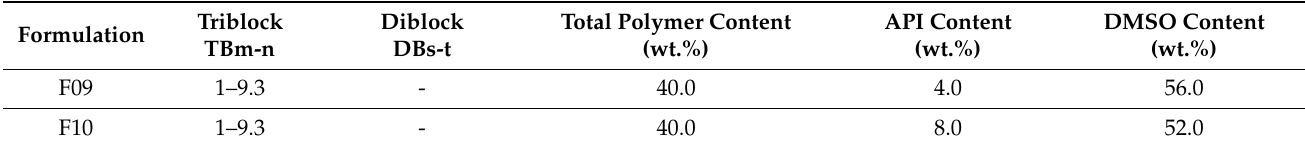
Table 2. Compositions of formulations delivering